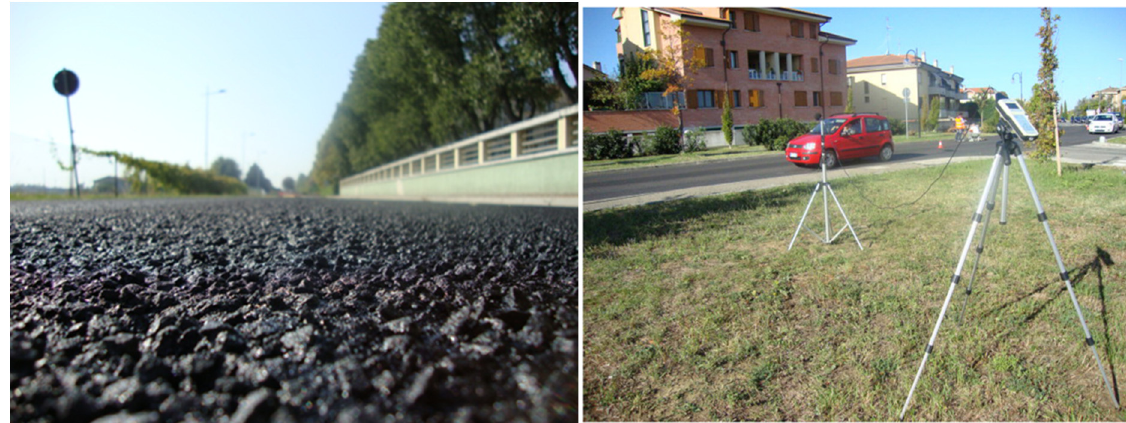
Figure 6. Multifunctional microsurfacings in Ozzano Emilia (Bologna,